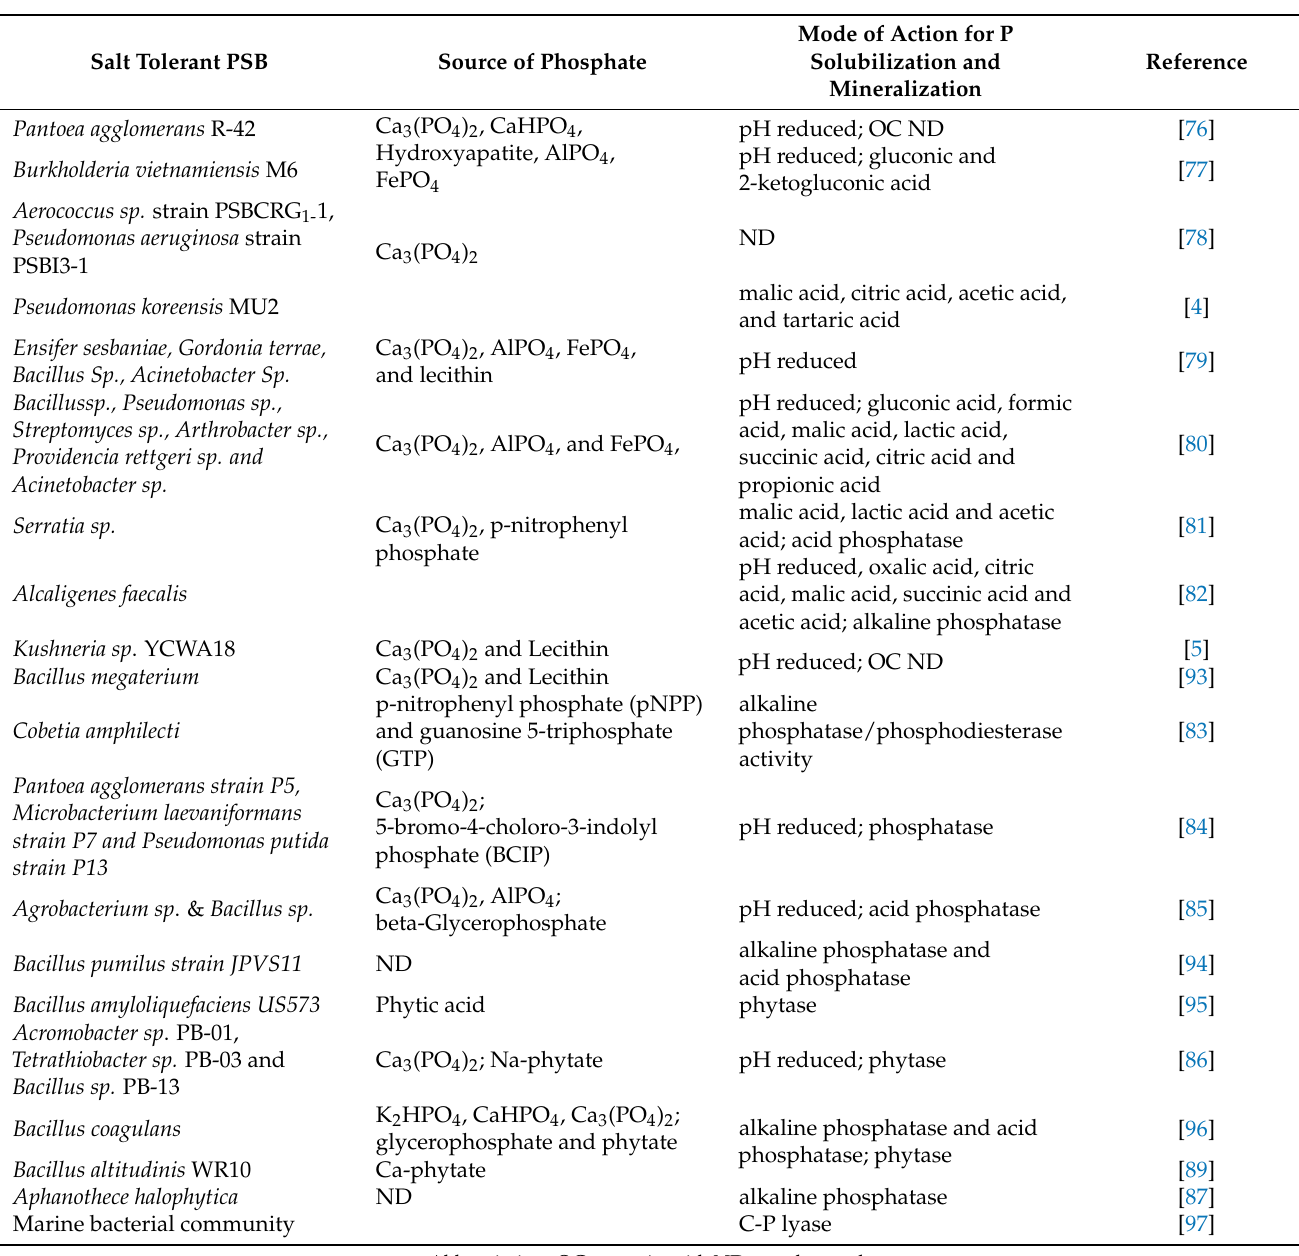
Table 1. List of ST-PSB and their possible mechanism for inorganic and organic phosphate solubilization and mineralization. Salt Tolerant PSB Source of Phosphate